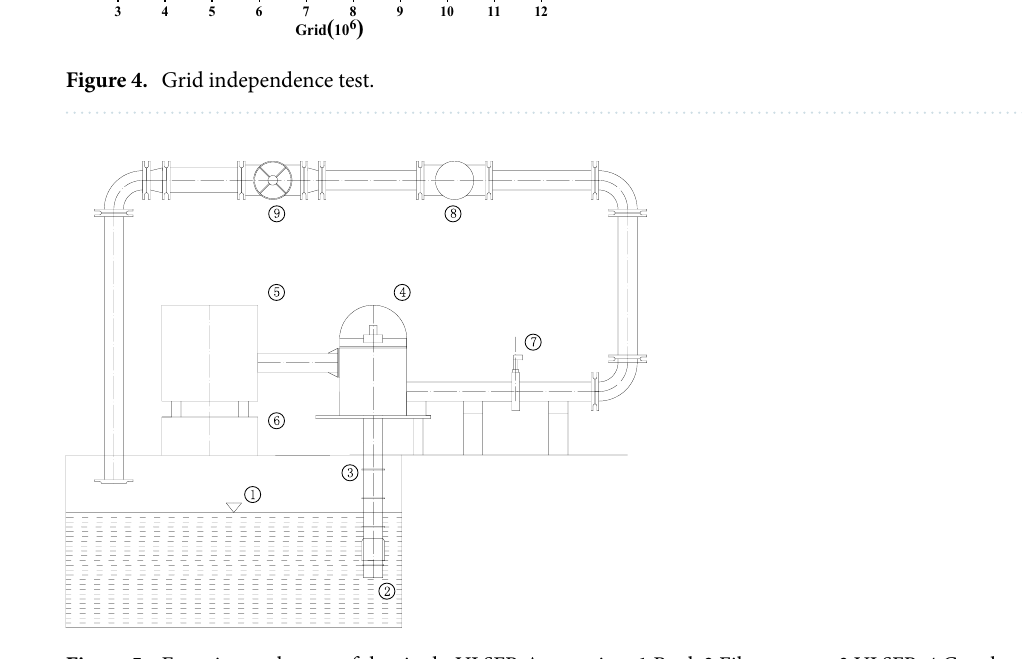
Figure 5. Experimental setup of the single-VLSFP. Annotation: 1 Pool; 2 Filter screen; 3 VLSFP; 4 Gear box; 5 Diesel engine; 6 Diesel engine base; 7 Pressure gauge; 8 Electromagnetic flow-meter; 9